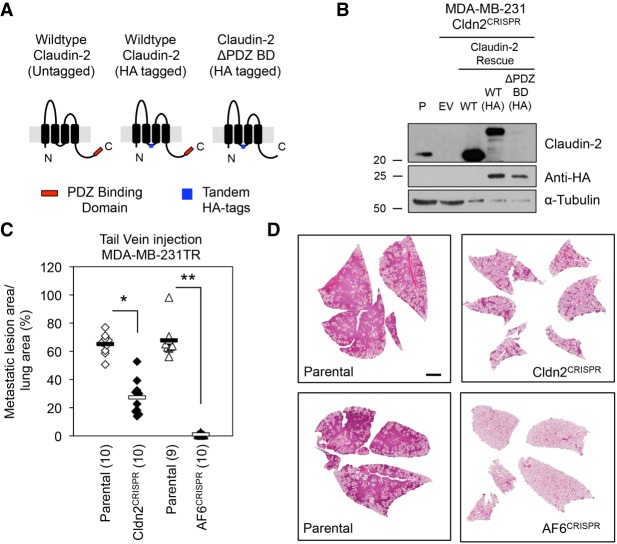
Claudin-2- or Afadin-deficient breast cancer cells are impaired in their ability to metastasize to the lung. (A) Schematic of Claudin-2 indicating the presence of the H-influenza HA tag in the cytoplasmic loop of wild-type Claudin-2 and the ΔPDZ BD Claudin-2 mutant. (B) Claudin-2 expression in the indicated MDA-MB-231-derived cell populations was analyzed by immunoblotting with anti-Claudin-2 and anti-HA antibodies. α-Tubulin served as a loading control. (C) Lung metastatic burden (tumor area per tissue area) was analyzed following tail vein injection of Claudin-2- and Afadin-proficient and Claudin-2- and Afadin-deficient MDA-MB-231 breast cancer cells. (*) P < 3 × 107; (**) P < 9 × 108. (D) Representative images of the lungs for each cell population are shown. Bar, 2 mm.